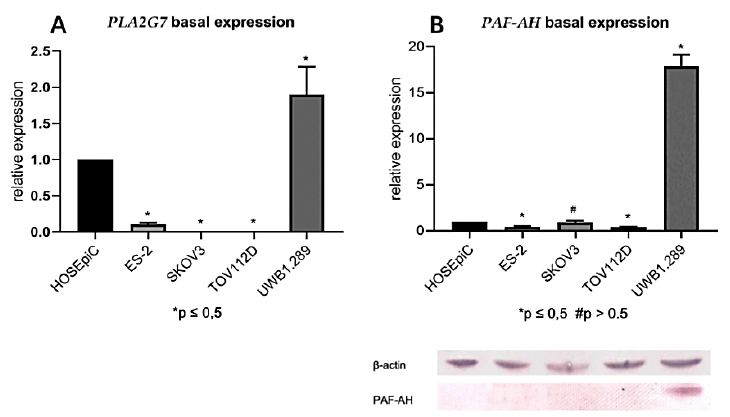
Figure 4. Only the BRCA1 mutant ovarian cancer cell line UWB1.289 showed a relevant expression of PLA2G7/PAF-AH. Basal mRNA (qPCR; ( A )) and protein (Western blot analysis; ( B )) expression of PLA2G7/PAF-AH in four ovarian cancer cell lines were compared to the expression in the benign ovarian cell line HOSEpiC. Significant results are indicated by asterisks (*: p ≤ 0.05), no significant results by diamonds (#: p > 0.05).